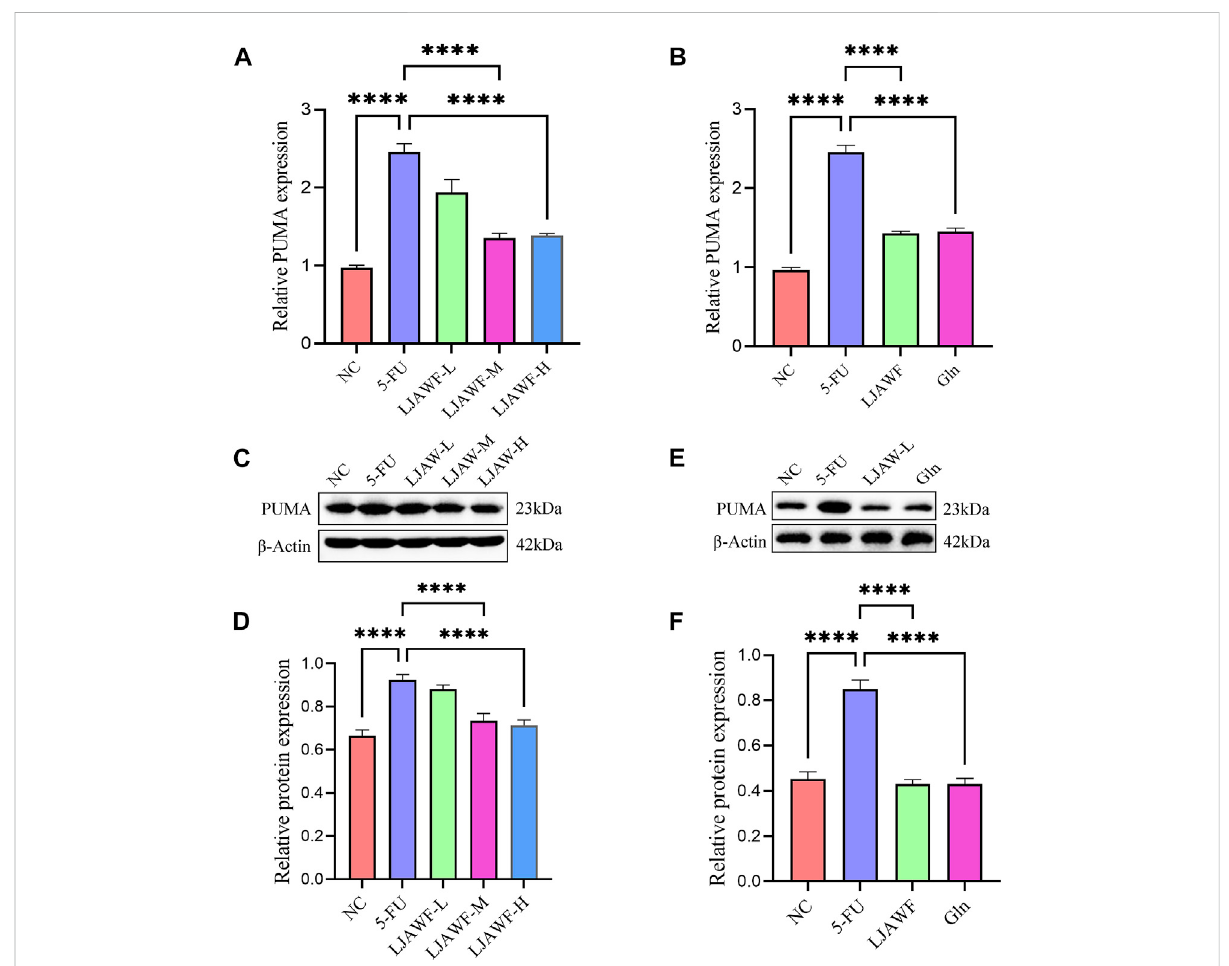
FIGURE 9 (A) and (B) The mRNA expression of PUMA in small intestine and organoids after treatment with LJAW (A) In small intestine (B) In organoids (C) – (F) The protein expression of PUMA in small intestine and organoids after treatment with LJAW (C) and (D) In small intestine (E) and (F)